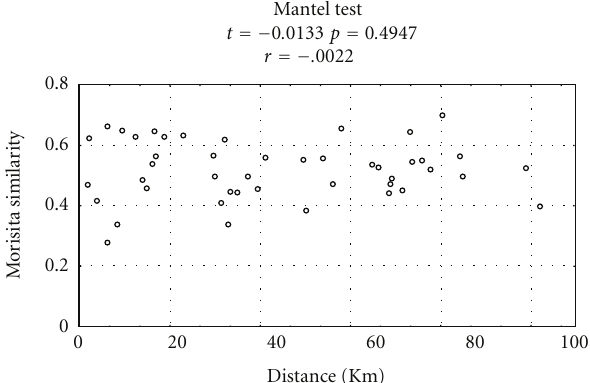
Figure 6: Mantel’s test analysis between the values obtained using the Morisita-Horn similarity index and the distance between sites